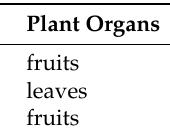
Table 2. Surveyed studies respective to hereby assessed vanilla crop WR or hybrid species and the plant organs from which the metabolites were